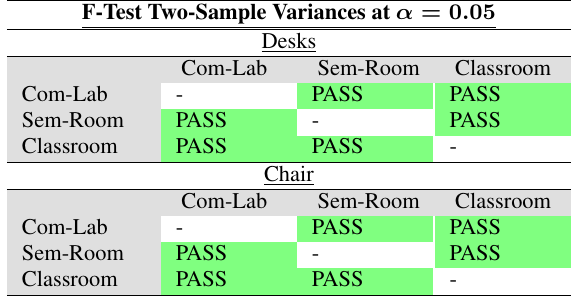
Table 7: Matrix of F-Test results for non-normalised